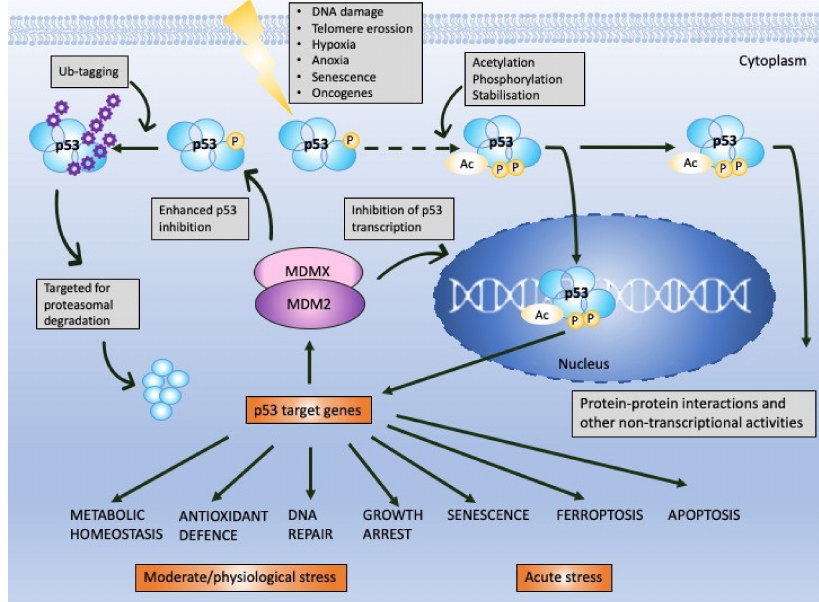
Figure 1. p53 and MDM2 as a hub of p53-dependent cellular responses—a simplified model. Under physiological conditions, p53 is degraded by MDM2, E3 ubiquitin ligase, which, depending on the level of cellular stress, can have either high or low a ffi nity to p53. MDM2 is responsible for p53 monoubiquitination (driving p53 nuclear export) and polyubiquitination of p53 (driving p53 ubiquitin-dependent proteasomal degradation) and prevents p53 acetylation and transcriptional activation by p300 acetyltransferase. The a ffi nity of MDM2 to p53 is enhanced upon hetero-dimerization with its homolog, MDMX protein. Upon stress, p53 undergoes phosphorylation and acetylation (the sites depend on the type and severity of stress) and recognizes its target genes. MDM2 and MDMX may prevent p53 from initiating the transcription through direct binding, which hinders the binding of the transcriptional co-activators. The sets of the target genes that become activated / repressed by p53 are often interrelated. In addition to transcription-dependent activity, cytoplasmic p53 functions through protein–protein interactions to modulate apoptosis, miRNA maturation or the repair of double-strand breaks (DBS). The dotted line represents a multistep process. Adapted from Levine, 2020 [13], Levine and Oren, 2009 [14] and Bode and Dong, 2004